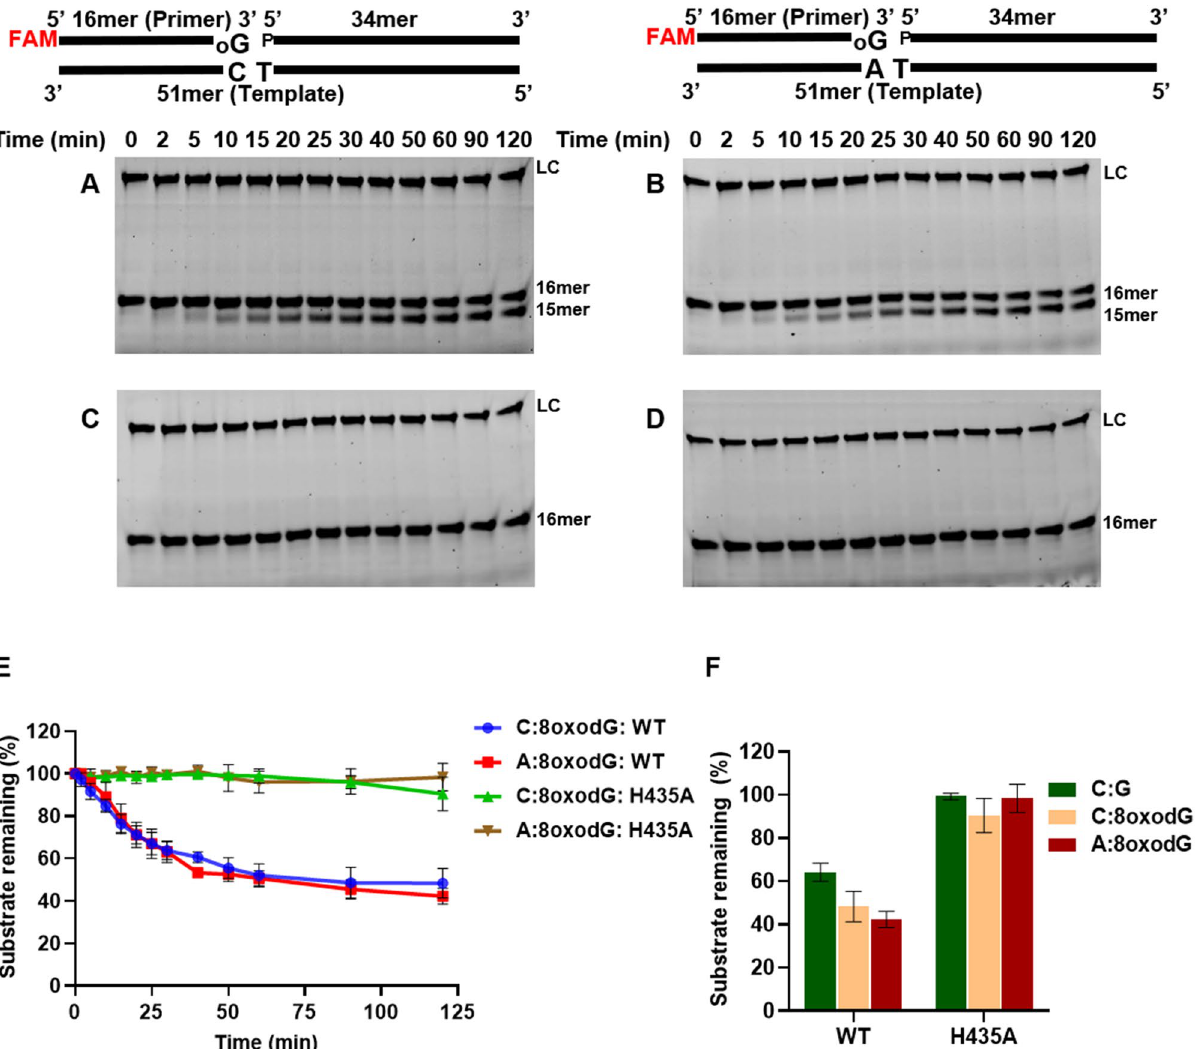
Figure 12. Exonuclease activity of wt-saPolX to remove 8oxodGMP present at primer terminus. Time-course analysis of exonuclease activity exhibited on gapped DNA bearing 8oxodG incorporated opposite templating C (C:8oxodG) and A (A:8oxodG) nucleotides in the presence of Mn 2+ by wt-saPolX (12.5 nM) ( A , B ) and H435A mutant (12.5 nM) ( C , D ), respectively, are displayed. LC represents the loading control added in each lane for quantification. The decrease in the levels of the substrates bearing 8oxodGMP at the 3 ′ end in the presence of Mn 2+ is shown in graph ( E ). The amount of substrate remaining after 120 min of incubation for DNA substrates C:8oxodG, A:8oxodG and C:G are compared (bar graph F ). These experiments show that wt-saPolX can excise out mis-incorporated oxidized nucleotides in the presence of Mn 2+ instrument. The data were acquired and were analyzed using ProteinPilot software using the Mascot method algorithm in the NCBI database. ESI–MS for wt-saPolX and H435A was carried out at the Advanced Technology Platform Centre (ATPC) using a protocol published previously 77 .